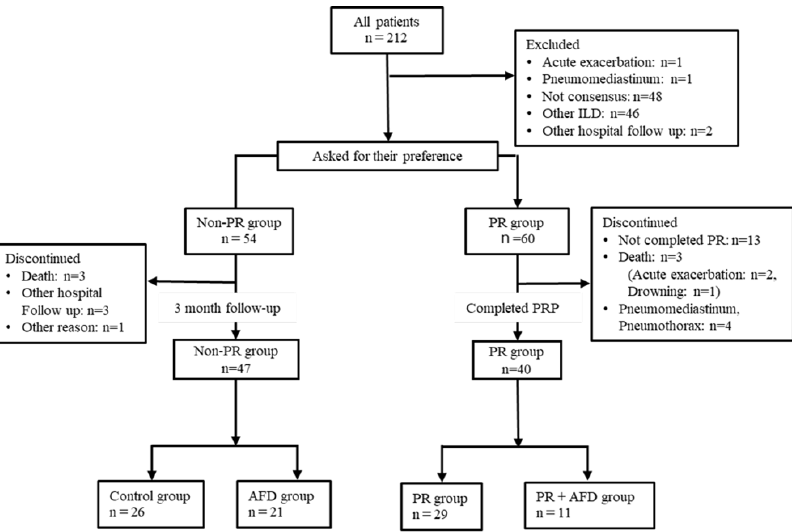
Figure 1. Participant selection flow diagram. Abbreviations: ILD, interstitial lung disease; PR, pulmonary rehabilitation; AFD, antifibrotic drugs.